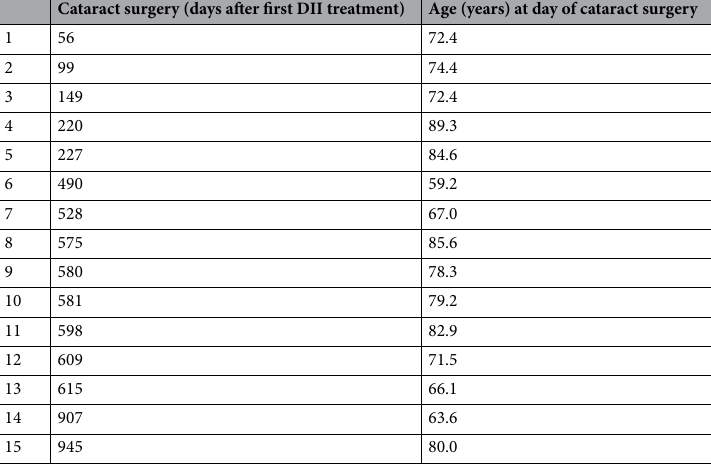
Cataract surgery (days after first DII treatment) Age (years) at day of cataract surgery